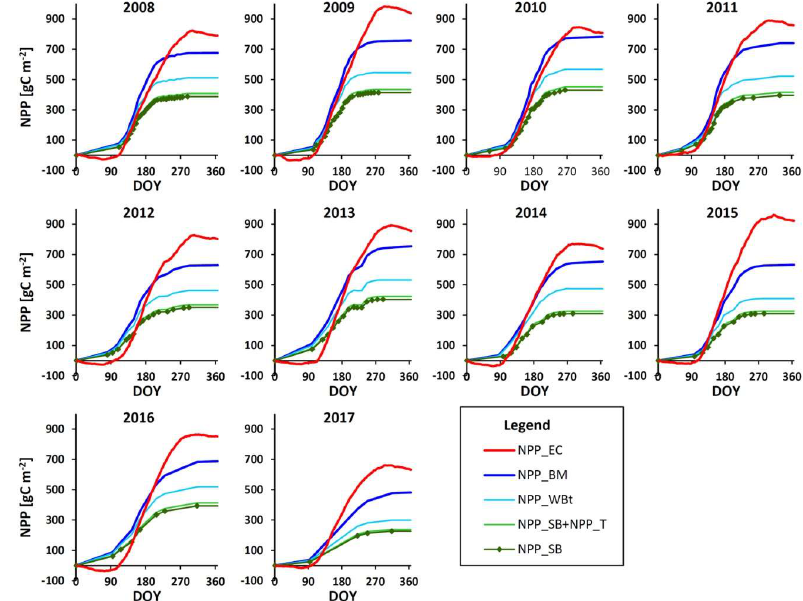
Figure 12. Comparison of cumulative NPP determined with EC method (red line) and with biometric measurements (blue line) in Jastrebarsko pedunculate oak forest for years 2008 until 2017 ( NPP EC —eddy covariance; NPP BM —biometric method; NPP WBt —total woody biomass including coarse roots; NPP T —twigs; NPP SB —stem and branches, points indicate Day-Of-Year ( DOY) of dendrometer measurements).